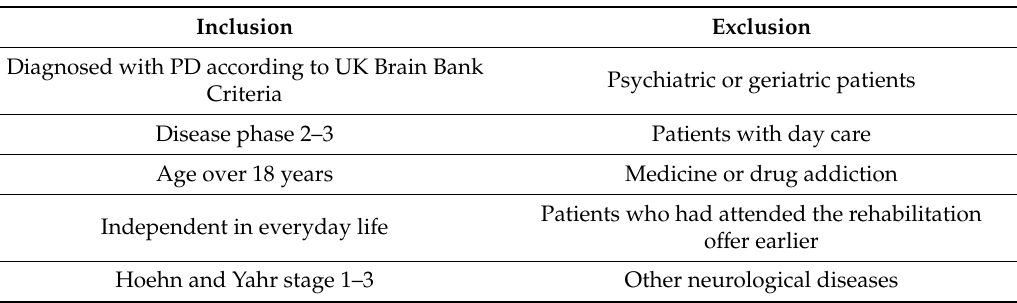
Table 1. In- and exclusion